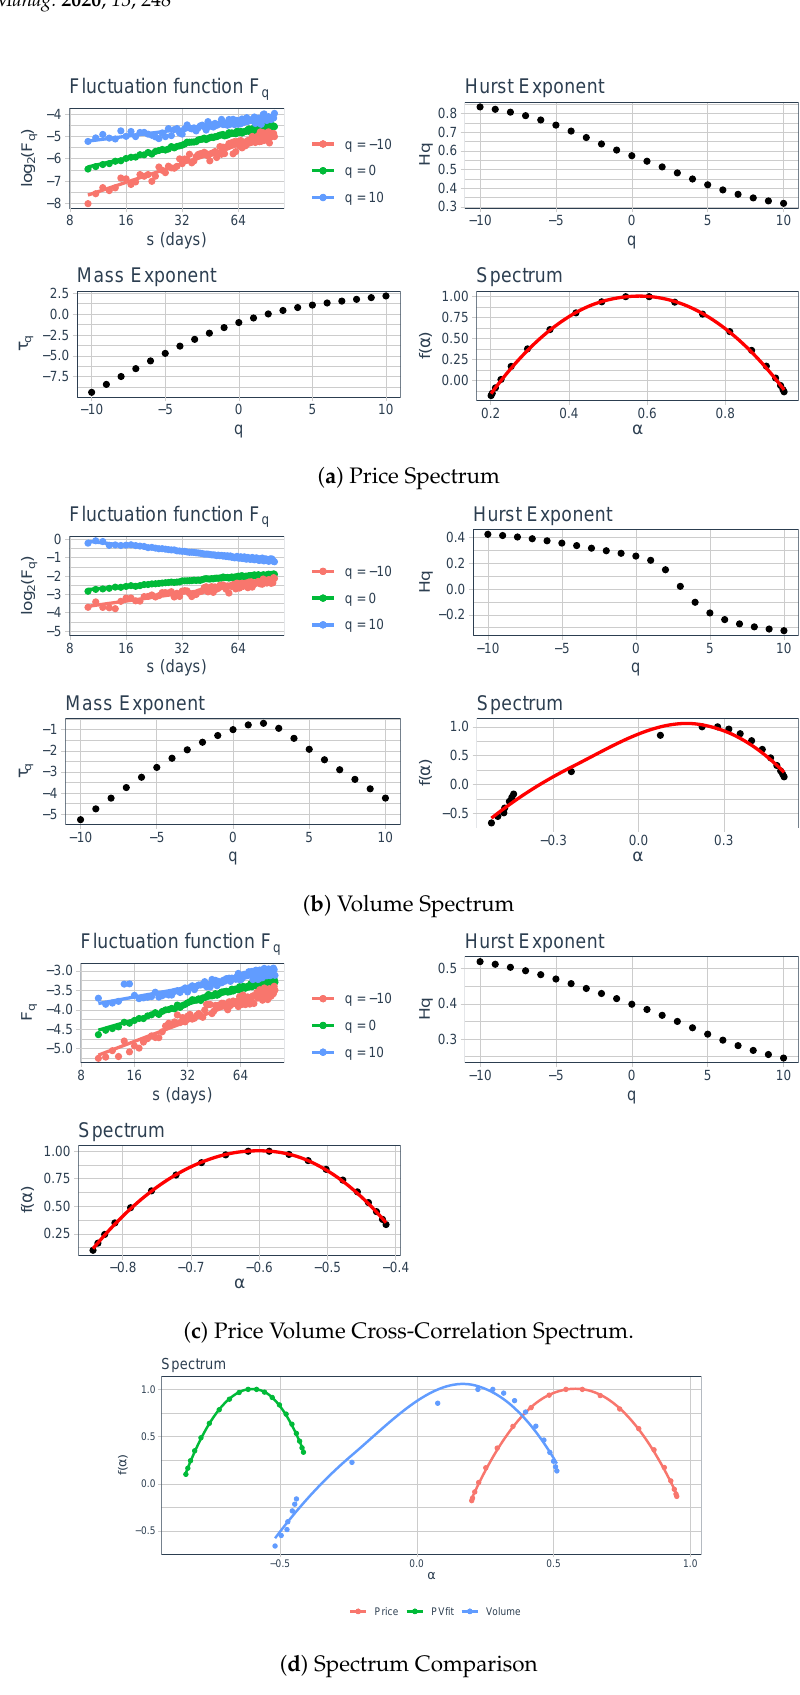
Figure 5. Segment 1 price, volume, and price-volume cross-correlation